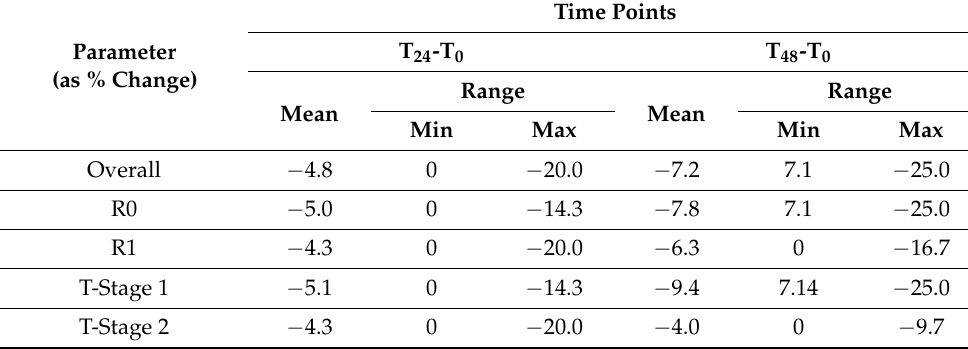
Table 3. Shrinkage of tumors as mean % at different time points, between R-classification and